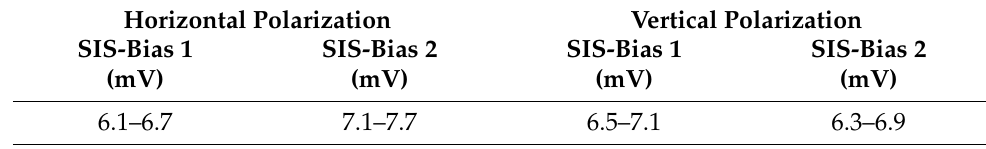
Table 3. Search ranges of SIS-Bias for measurement of IRR.